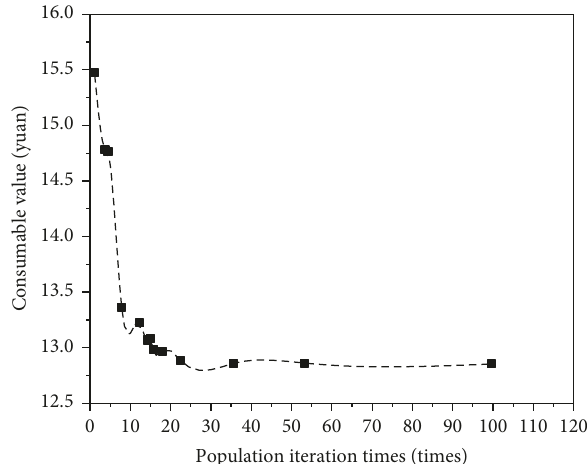
Figure 8: Diagram of genetic energy consumption value pursuit evolution.